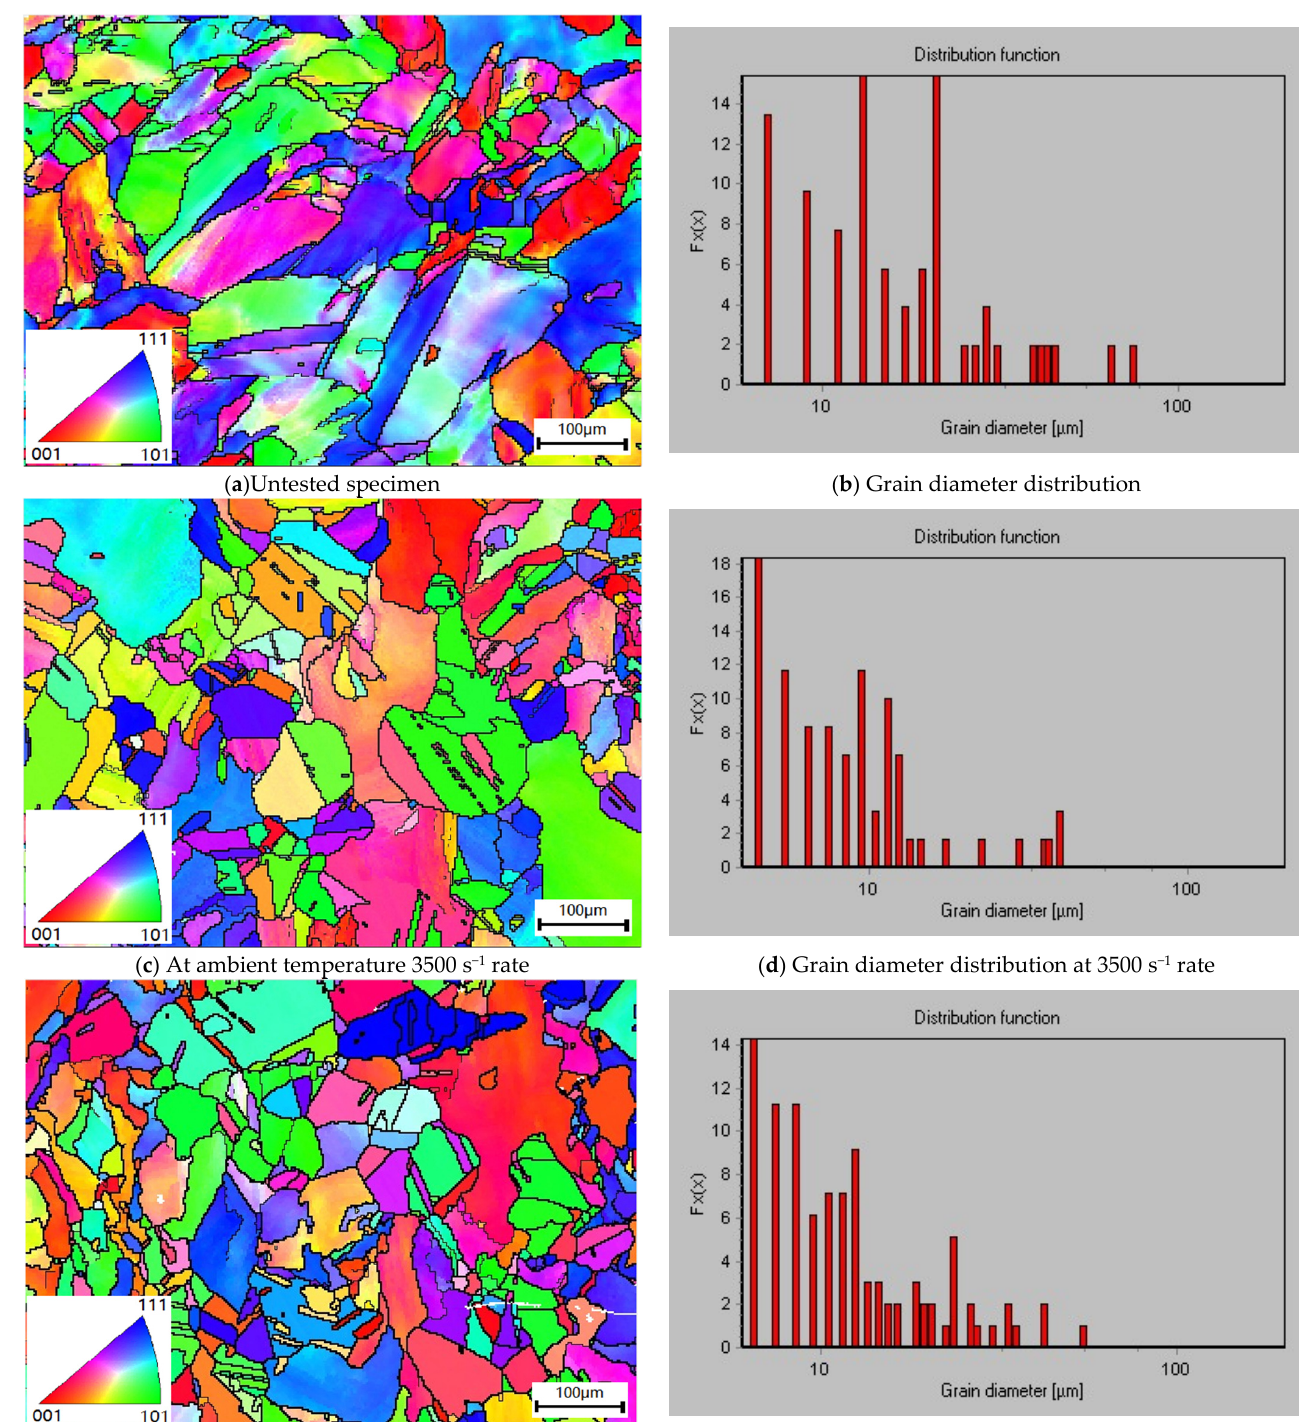
Figure 17. EBSD microscopy of dynamically compressed specimens.